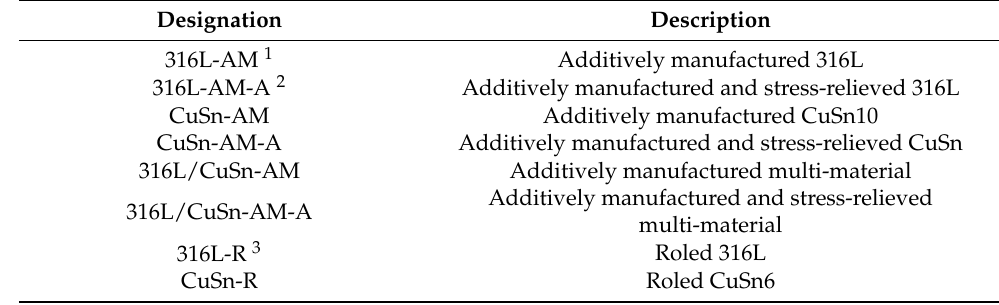
Table 2. List of investigated